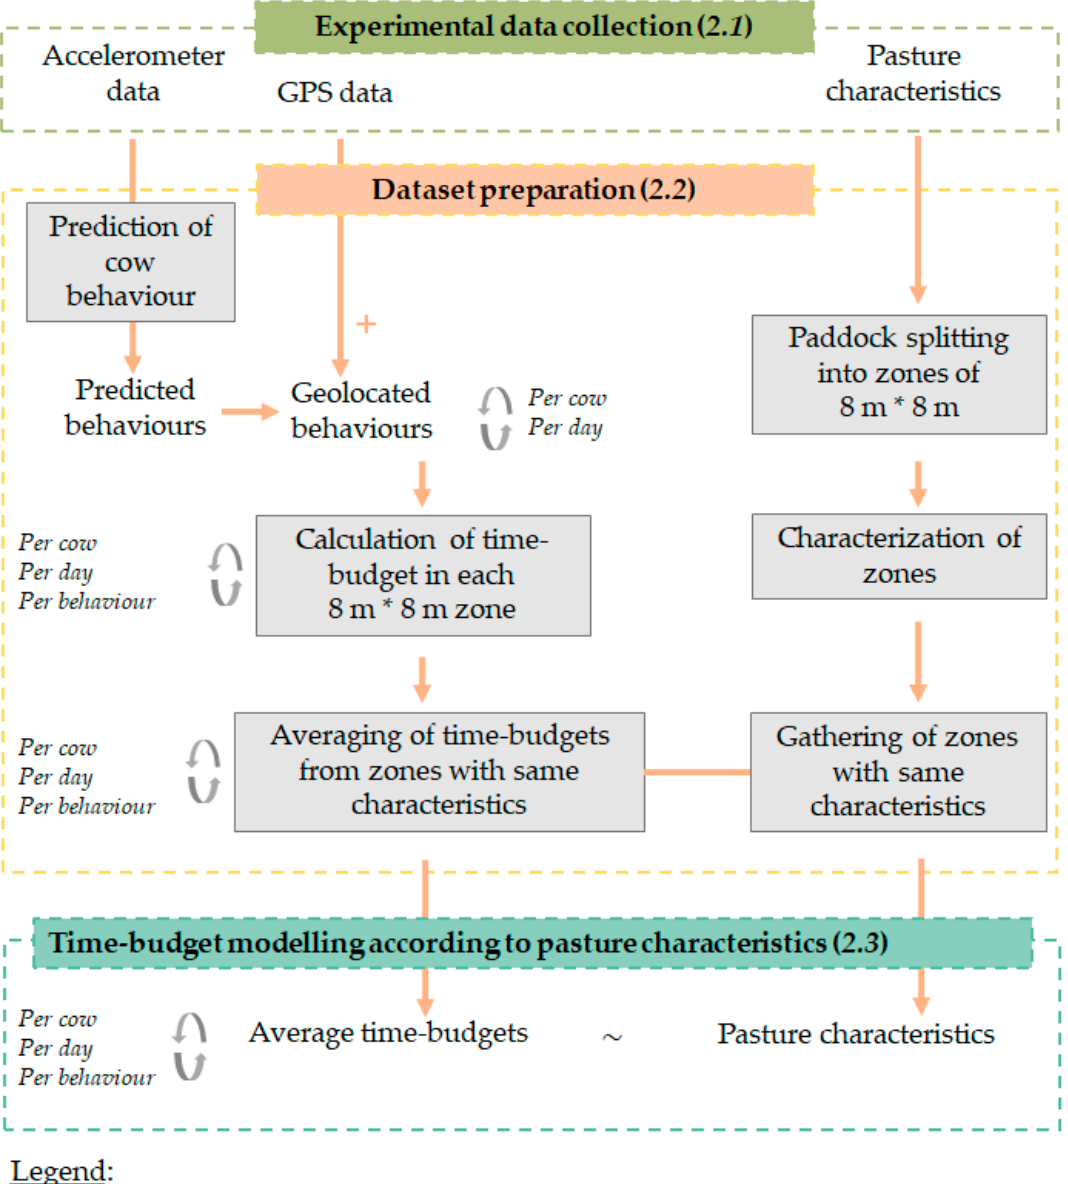
Figure 1. Overview of the main steps applied in the Material and Methods section.